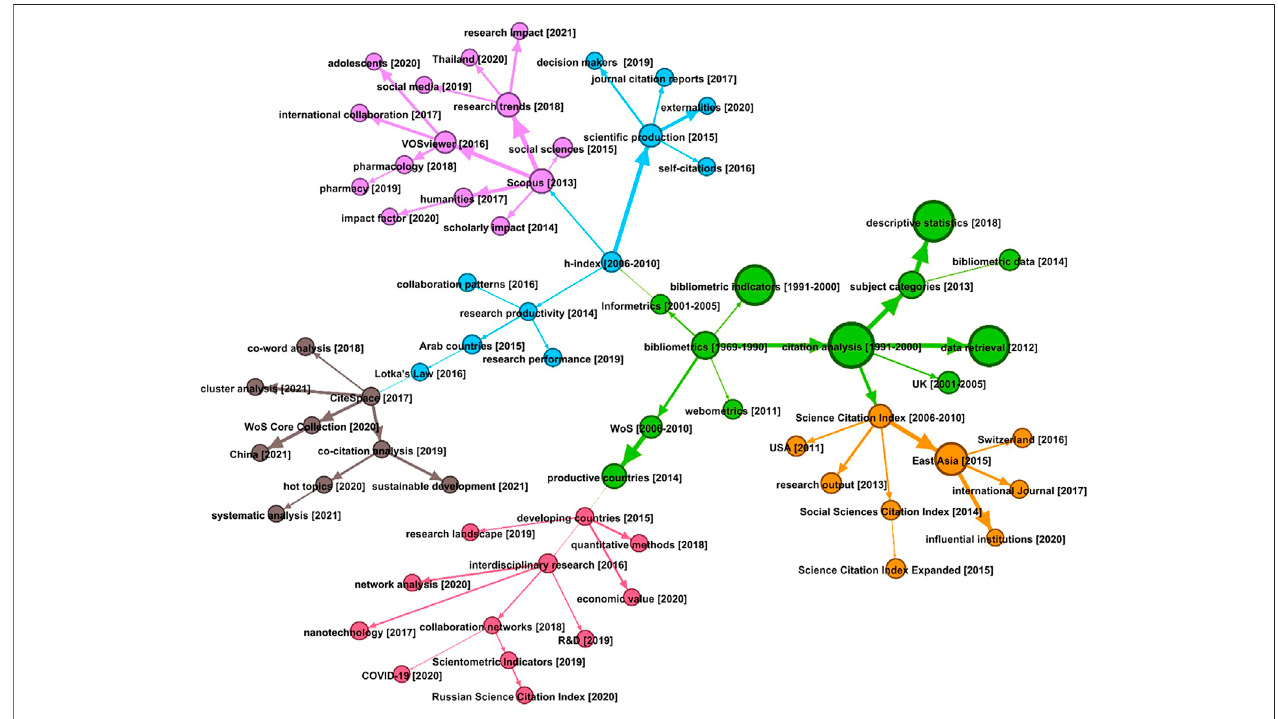
FIGURE 8 | Scienti fi c evolution pathways of bibliometric research between 1969 and 2020.